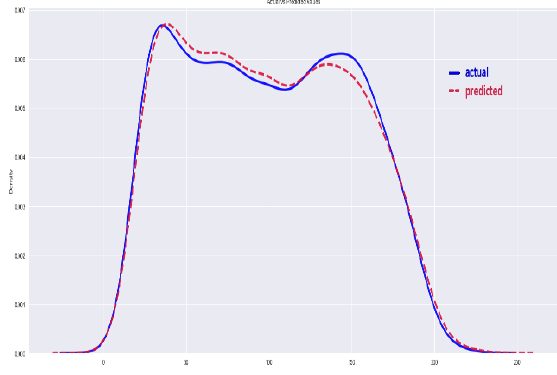
Fig. 7. Actual vs Predicted for Maximum Power using Linear Regression